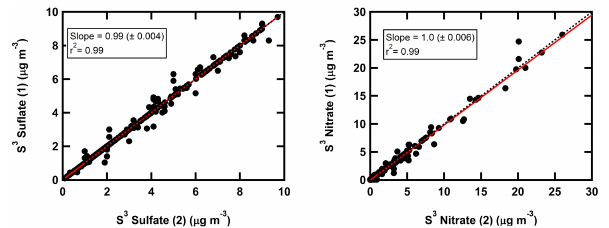
Figure 5. Intercomparison of PM 2 . 5 nitrate and sulfate collected us- ing two S3 systems during the San Gorgonio, CA study. The dotted lines show a 1 : 1 relationship, and the solid lines show the results of a least-squares linear regression fit with the intercept forced through the origin.